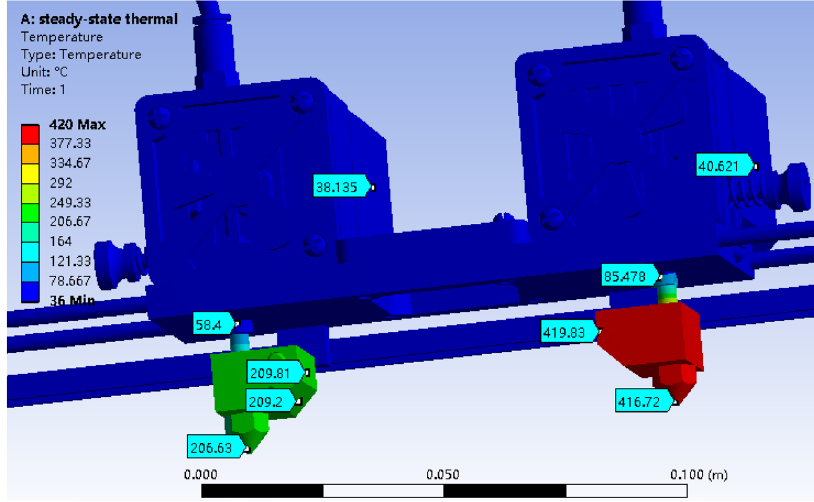
Figure 3. Temperature profile of the designed nozzle system.